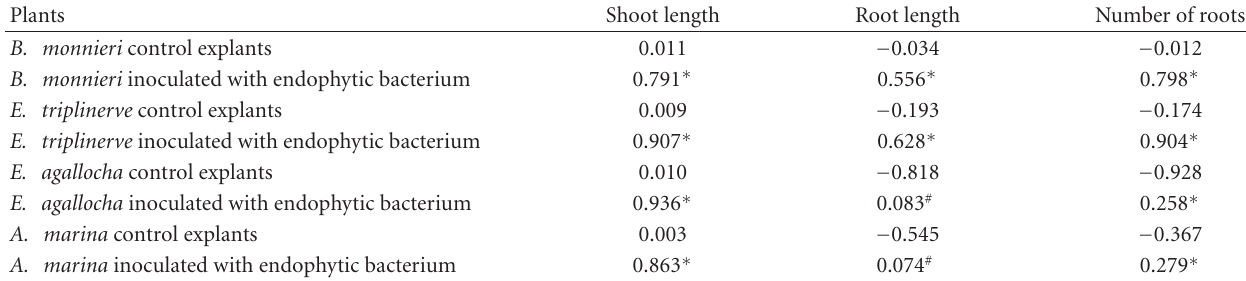
Table 5: Two-way ANOVA for the di ff erences in shoot length, root length, and number of roots of inoculated and control explants.